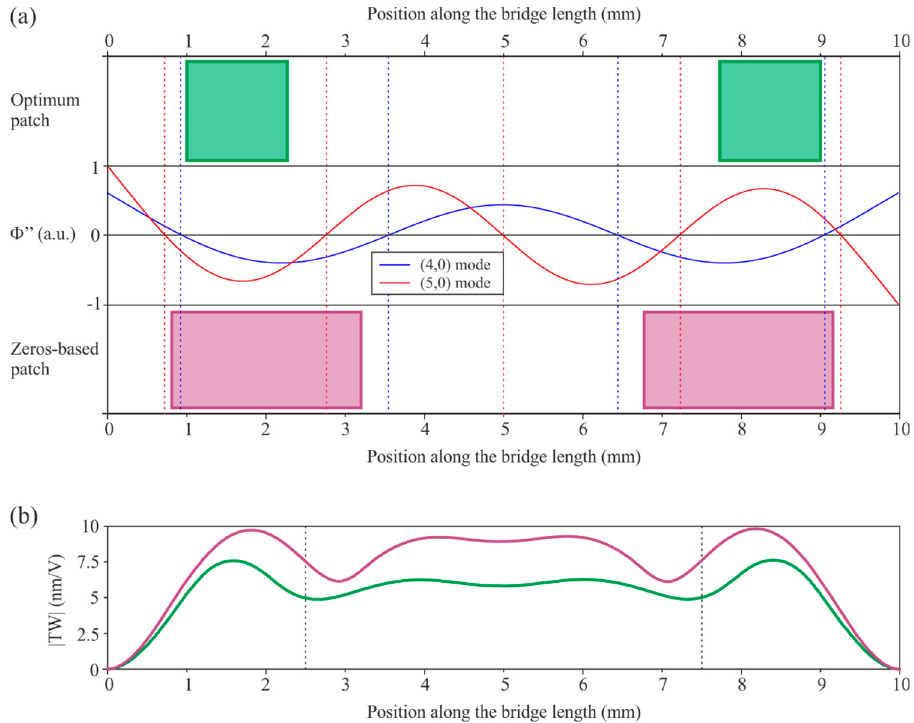
Figure 3. ( a ) Second derivatives Φ′′ (solid lines) of the modes involved in the travelling wave (TW) generation. The position of the zeros (dotted vertical lines) and optimum patch design (green area) and zeros-based patch (purple area) are also indicated. ( b ) Resultant TW envelope from the simulations with the optimum patch and the zeros-based patch. Dotted vertical lines indicate a centered 50% of the length.